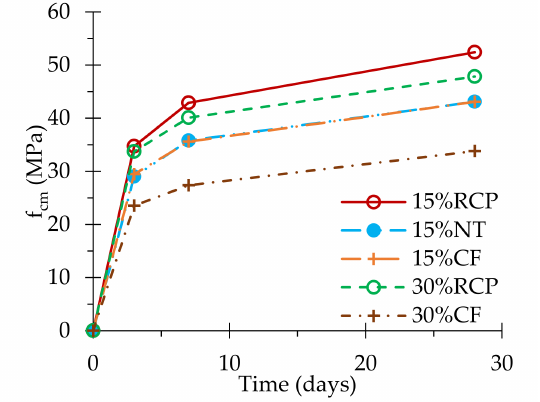
Figure 13. Compressive strength, f cm , over time of concrete with a w/b of 0.55, incorporating 15–30% of different